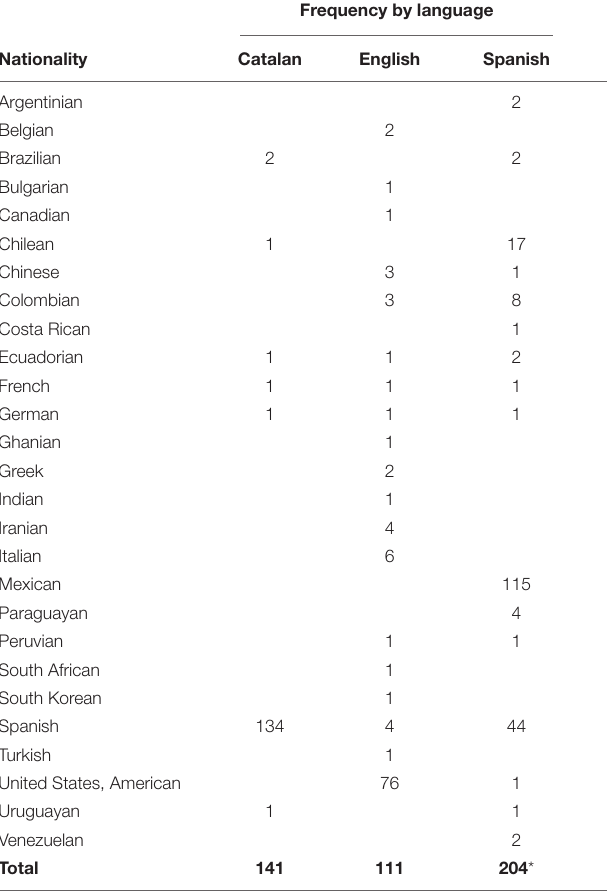
TABLE 1 | Nationalities represented by